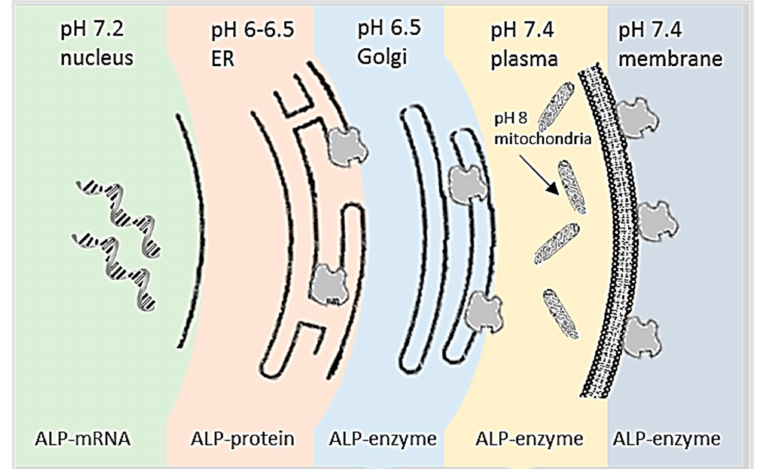
Figure 3. ALP produced in each stage in cells